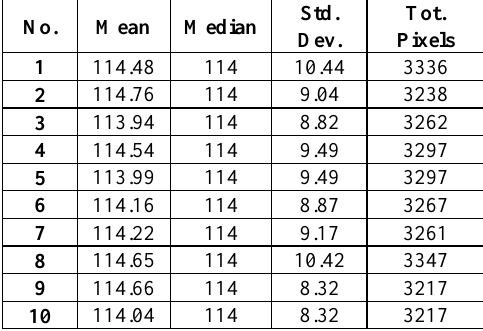
Table3. Magic Wand process on Homomorphicaly Filtered Test Image#1